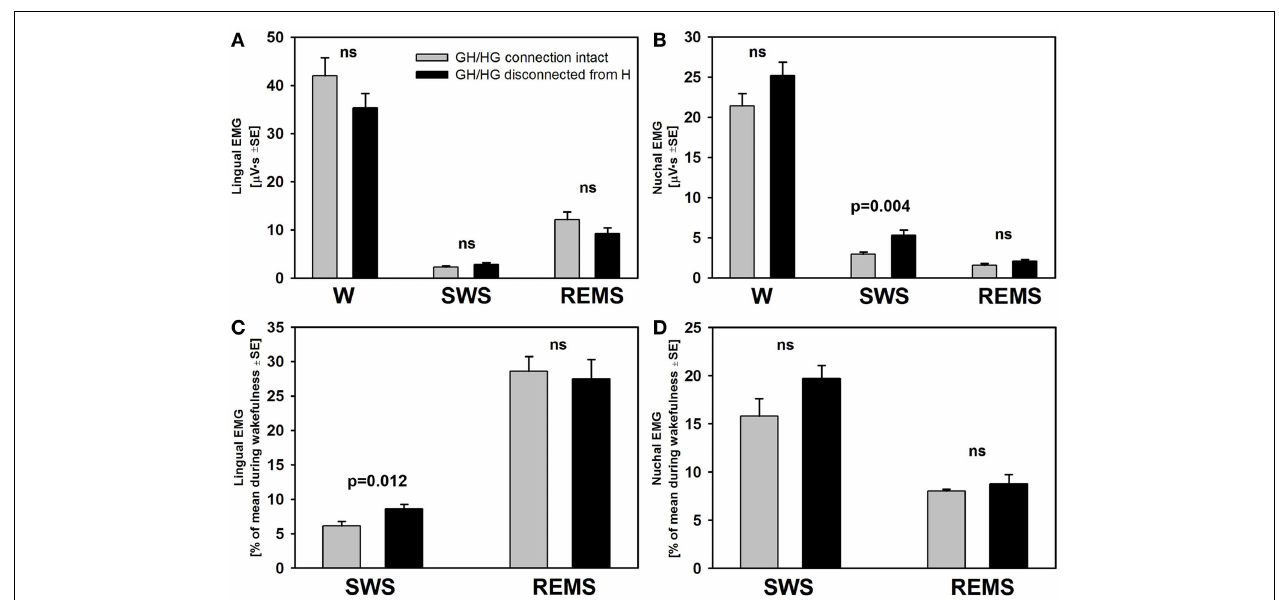
injury applied to the ventral neck region.When lingual and nuchal EMG levels during sleep were quantified relative to their levels during wakefulness (C,D) , lingual EMG during SWS was significantly higher in the rats with altered upper airway when compared to control rats, whereas there was only an insignificant trend in this direction for nuchal EMG. See text for alternative interpretations of this finding. Bars show average data derived from 24 recording sessions with 5 control rats and 25 recording sessions with 5 experimental rats. ns – not significant difference between the control and experimental